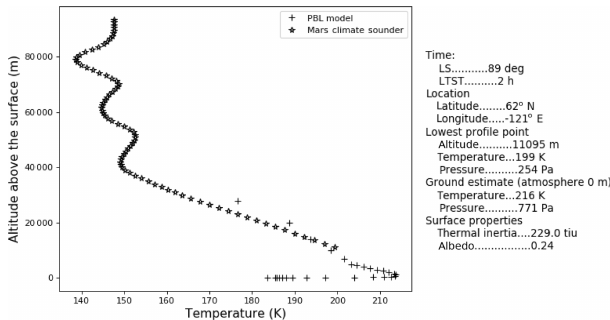
Figure B1. A visual comparison of a MCS temperature profile and a model run without the adiabatic term. This is a result of entering “1” into the analysis input field in the GUI shown in Fig. 3.